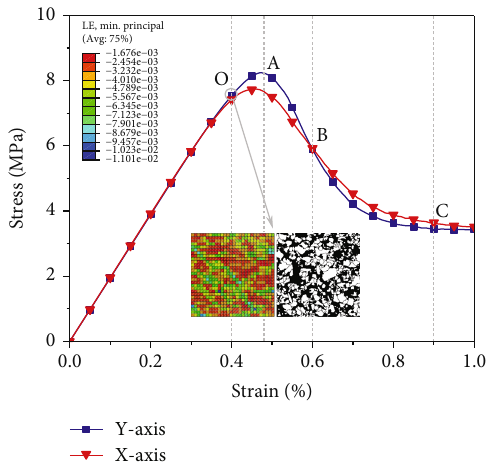
Figure 4: Stress – strain relationship of the S3-MRR under two loading